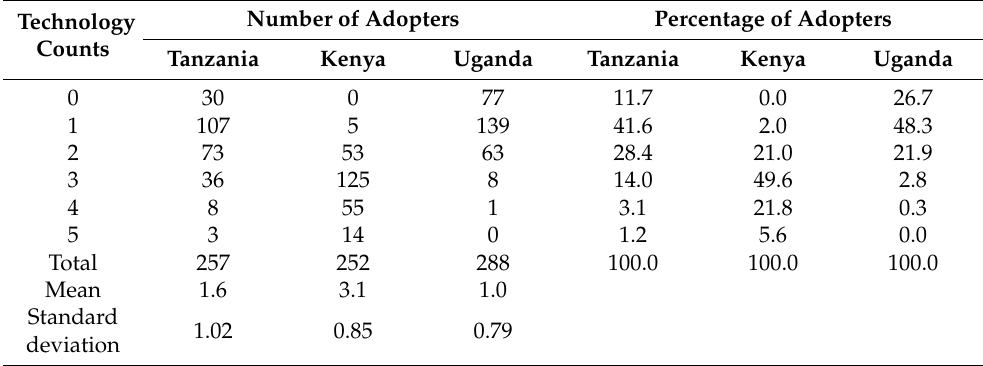
Table 4. Distribution of counts of mungbean production technologies